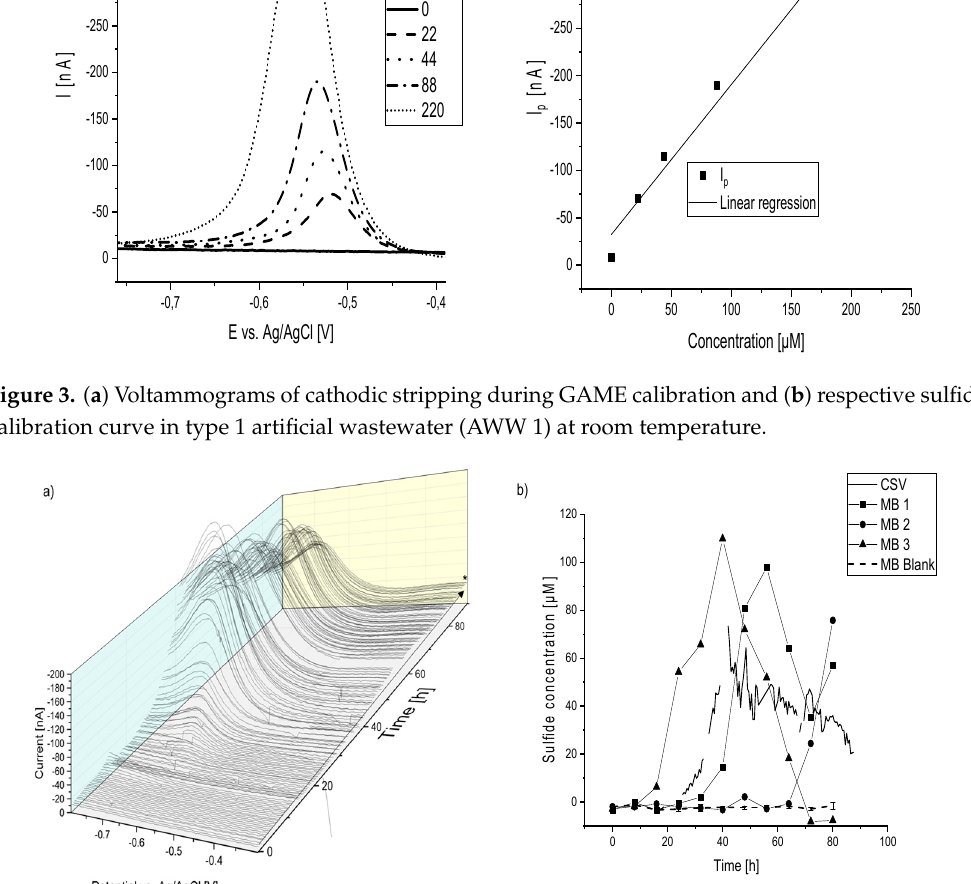
Figure 4. Microbial sulfide emission in AWW 1 over time. ( a ) Cathodic sweeps with stripping peaks. ( b ) Derived sulfide concentrations by cathodic stripping voltammetry (CSV) and the Methylene Blue method.